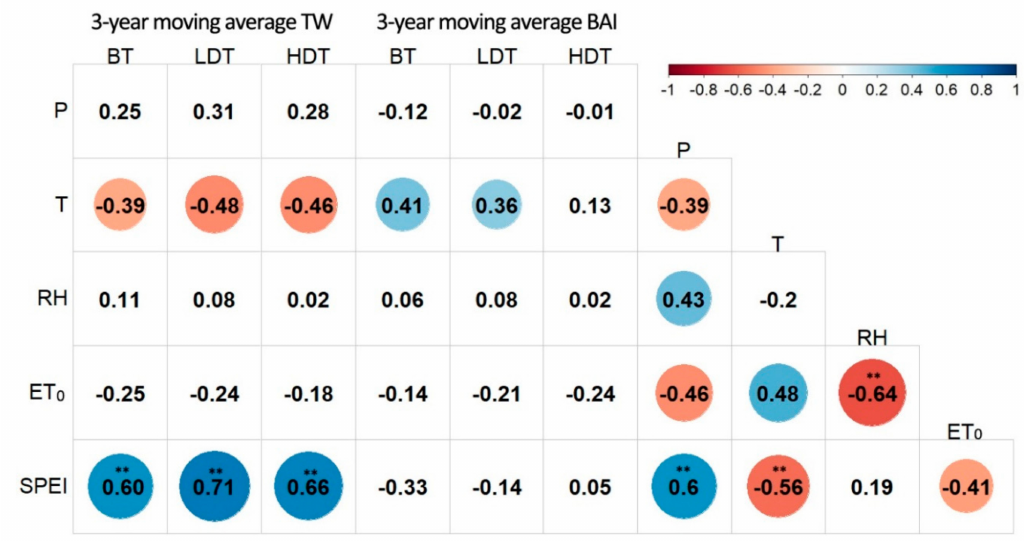
Figure 5. Pearson correlation coe ffi cients for 3-year moving average tree-ring width (TW) and basal area increment (BAI) with mean annual climatic factors for Mongolian pine trees of the three density groups at an annual